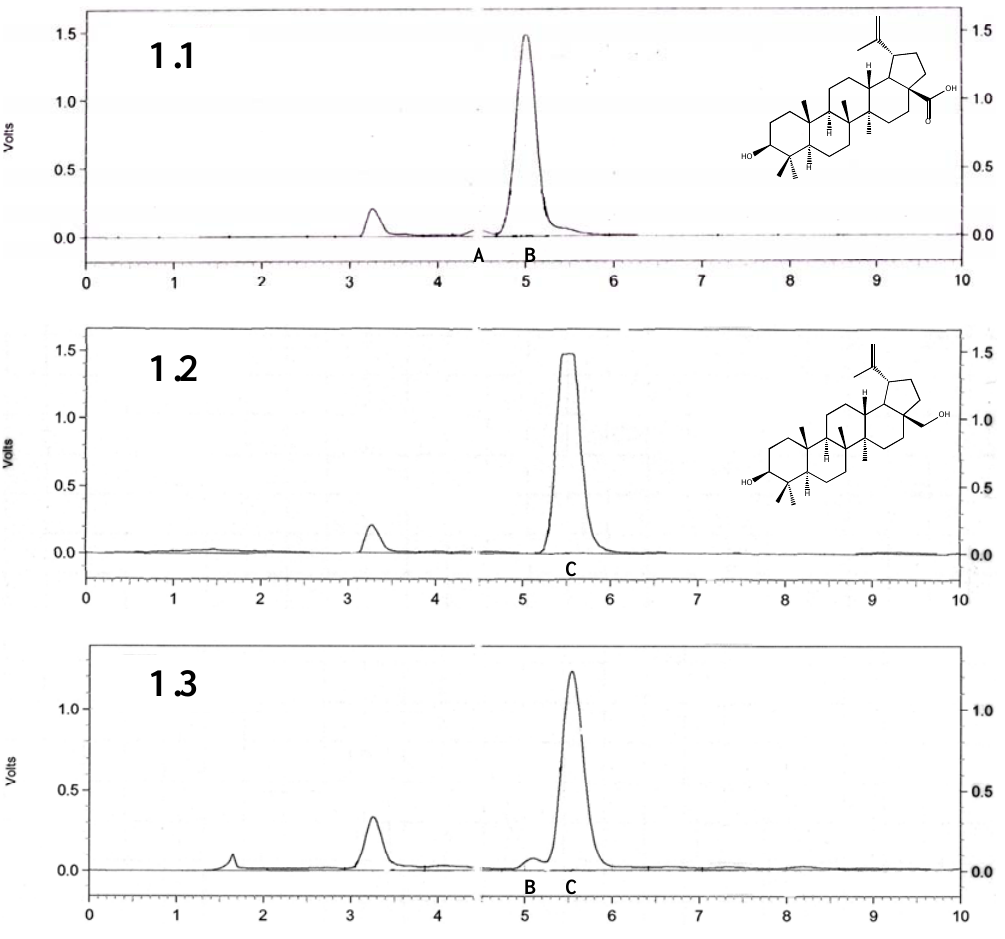
Figure 1. HPLC analysis: 1.1 betulinic acid, A epimer α and B epimer β of the compound; 1.2 betulin chromatogram, C betulin; 1.3 birch bark extract, B epimer β of the betulinic acid, C